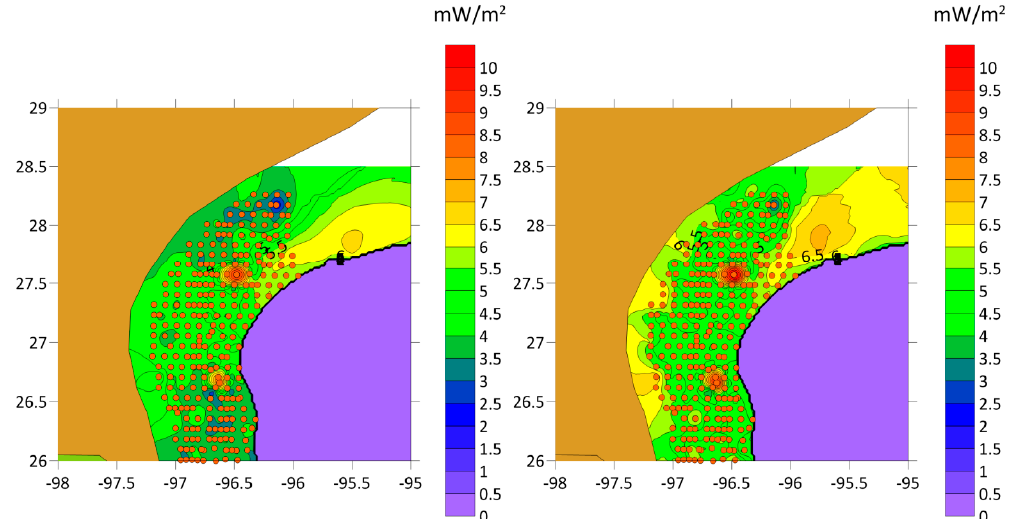
Figure 6. Calculated MFC power density in February ( left ) and August ( right ) on the Texas shelf in the Gulf of Mexico.